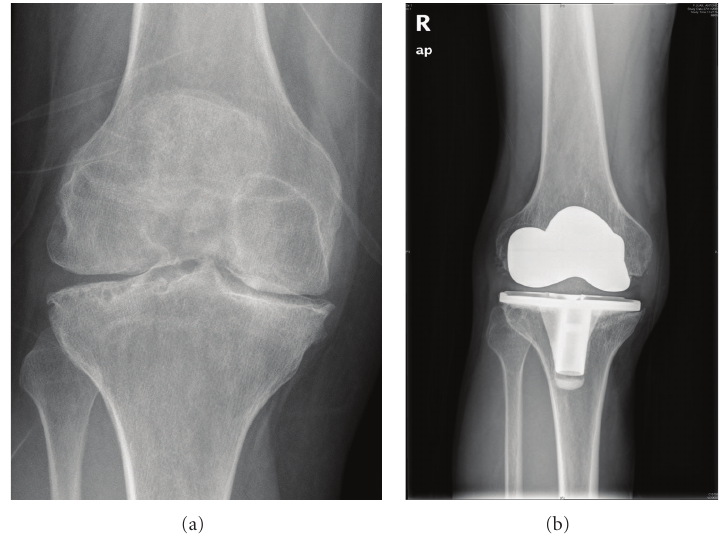
Figure 4: Severe arthropathy of the knee joint (a) that required a total knee arthroplasty (b), with a satisfactory